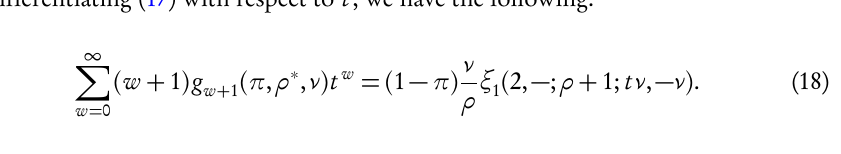
On differentiating (17) with respect to t , we have the